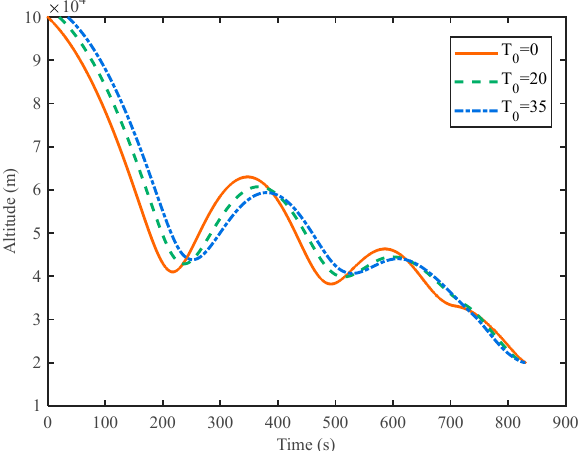
Figure 8. Time histories of the altitude.